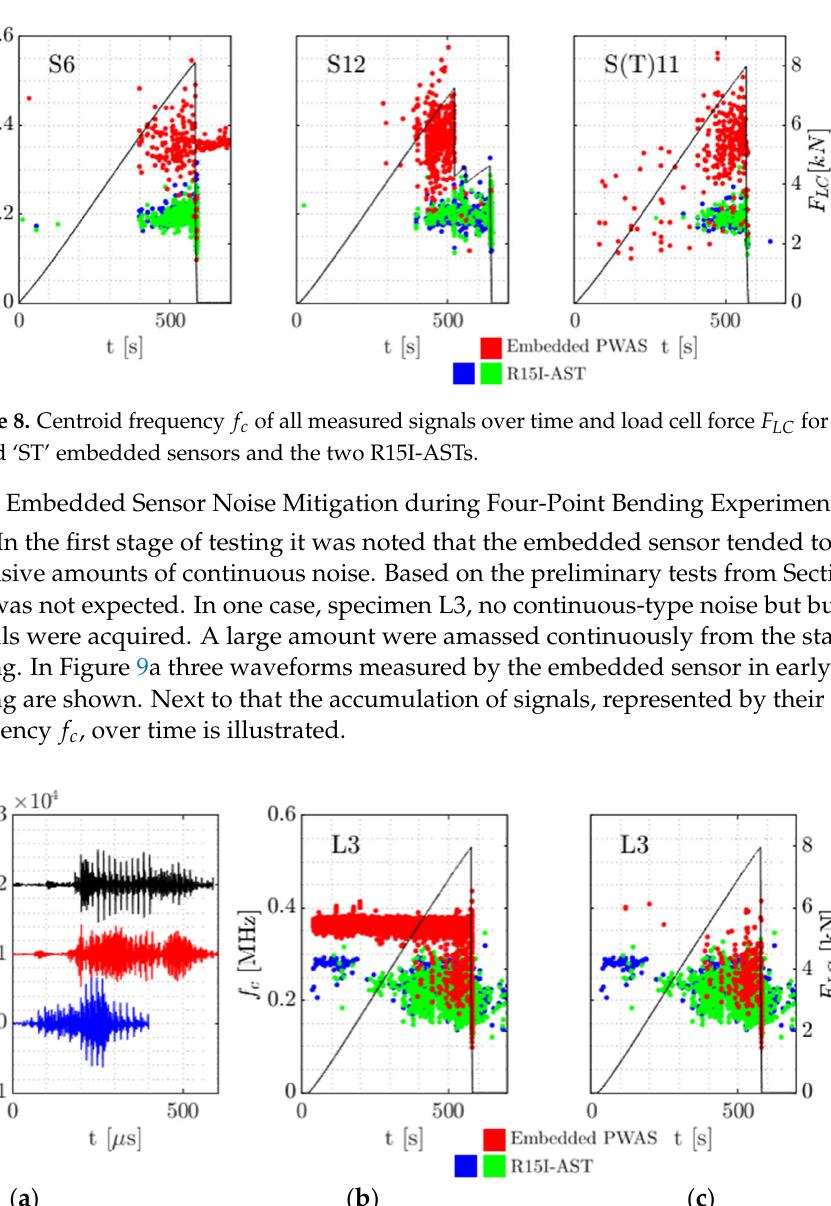
Figure 7. Centroid frequency 𝑓 (cid:3030) of all measured signals over time and load cell force 𝐹 (cid:3013)(cid:3004) for the large ‘L’ embedded sensors and the two R15I ‐ ASTs. Note L3 has been subject to noise re ‐ moval as is explained in Section 3.1.3. The final outcome is shown here.